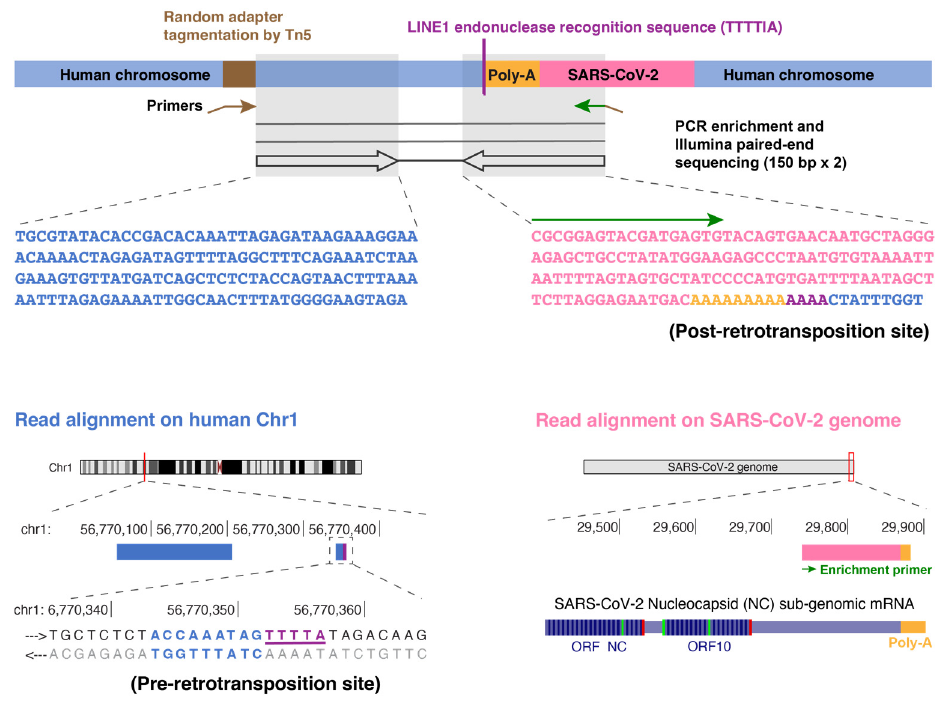
Figure 1. TagMap method for the enrichment and sequencing of a junction of retrotransposed viral cDNA sequence with its flanking human chromosome sequence. Schematic and an example sequencing read-pair showing the enrichment of one junction of retrotransposed viral cDNA. This method is based on random Tn5 tagmentation on cellular genomic DNA. A primer targeting the inserted adapter sequence (brown arrow) and a primer targeting a SARS-CoV-2 sequence (green arrow) are used to enrich the retrotransposition junction. In this example, the left read mapped to human chromosome 1 (blue). The right read mapped to the 3 ′ -end of a SARS-CoV-2 RNA sequence (pink) starting from the enrichment primer sequence (green arrow), covering a poly-A tract (orange) and ending with a human sequence (blue) at the retrotransposition site containing a LINE1 endonuclease recognition sequence (TTTT/A, purple).